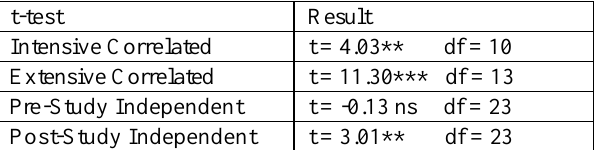
Table 4.7 Modified Cloze-Test